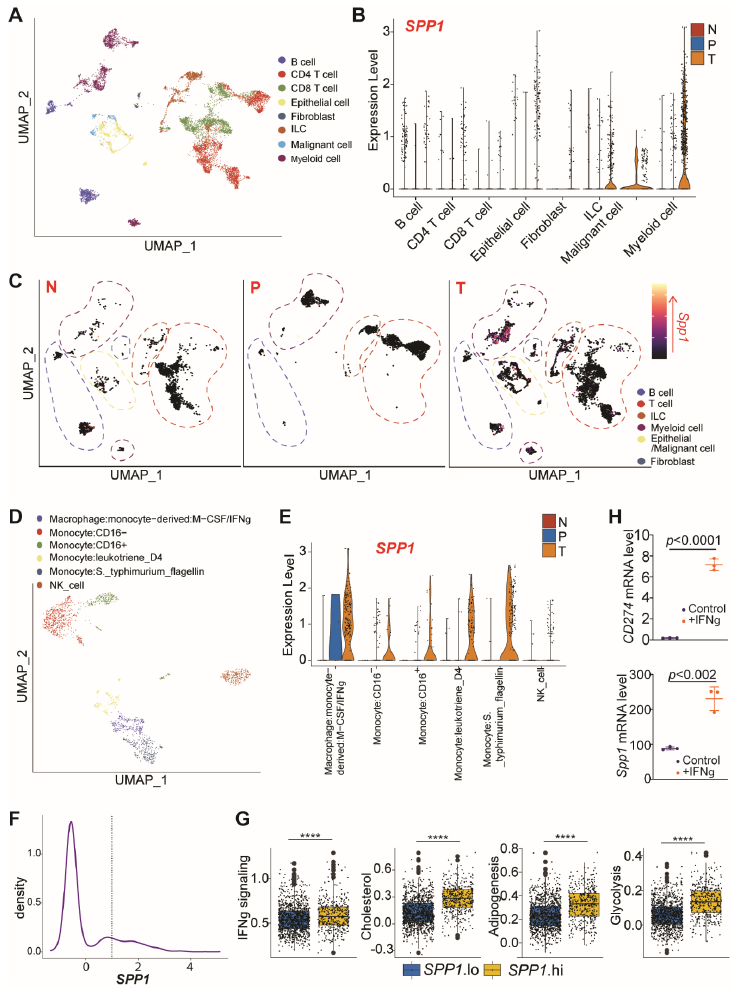
Figure 2. OPN expression profiles in the single cell level in human colorectal cancer patients. ( A ) UMAP projection of GSE146771 CRC 10× scRNA-seq data. Cells are annotated according to author’s designation. ( B ) Expression of SPP1 in indicated cells, sub-grouped by tissue of origin. N: Normal Colon; P: PBMC; T: CRC. ( C ) UMAP projection of SPP1 ex- pression, with cells sub-grouped by tissue of origin. ( D ) Sub-grouping and re-clustering of author-designated myeloid cells. Cluster identities were determined by comparison to Human Protein Atlas reference samples by SingleR. ( E ) Expres- sion of SPP1 in indicated cell clusters, sub-grouped by tissue of origin. ( F ) Density plot of SPP1 expression across all myeloid cells. Cells with expression level of SPP1 > 1 were designated as SPP1 .hi; the remainder designated as SPP1 .lo. ( G ) Comparison of hallmark gene signature scores computed by VISION between SPP1 .hi and SPP1 .lo cells. **** p < 1 × 10 − 15 . (H) CT26 cells were treated with IFN γ for approximately 24 h, and analyzed by qPCR for Cd274 and Spp1 expression. β -actin was used as internal control.